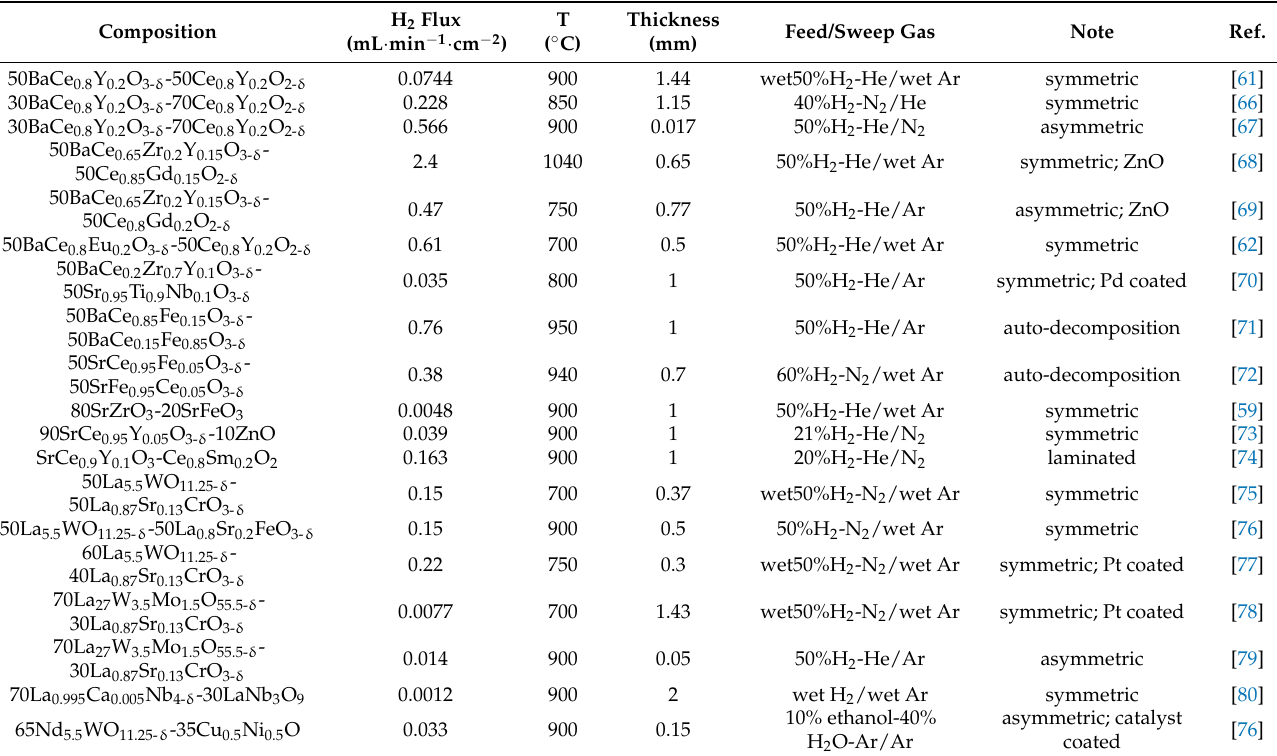
Table 2. Cercer dual-phase membranes and the hydrogen-permeation